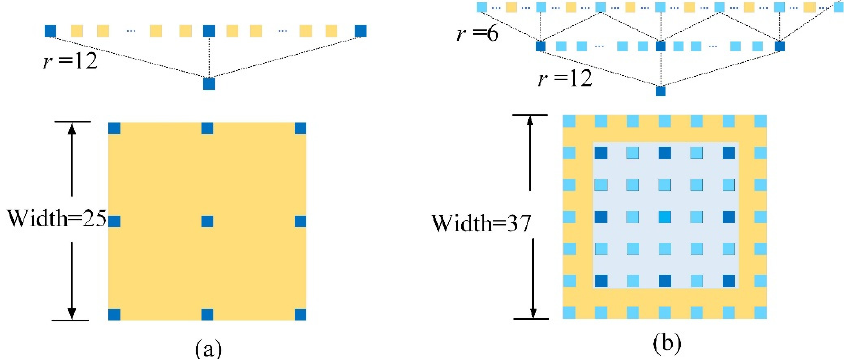
Figure 6. Distribution of atrous convolution sampling before and after dense connection. ( a ) Before dense connection; ( b ) After dense connection. dense connection; ( b ) After dense